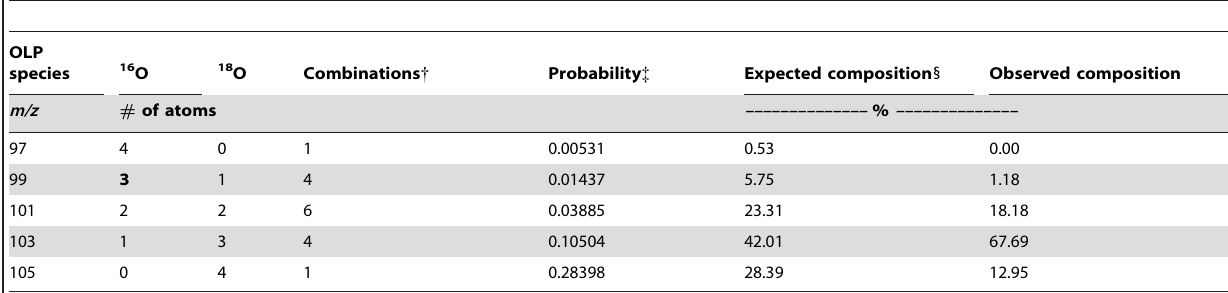
Table 4. Calculation of the expected amount of each oxygen labeled phosphate (OLP) species formed with completely random assortment of the oxygen atoms and comparison to the actual results from OLP synthesized with fresh POCl 3 in December 2008.